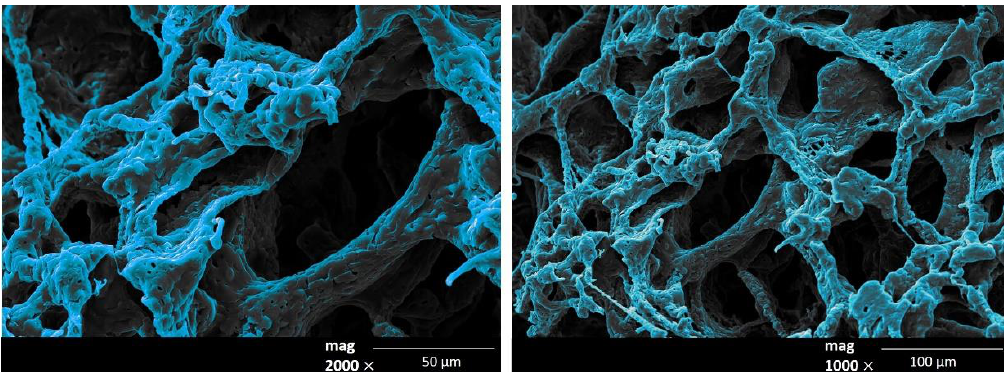
Figure 1. Scanning electron microscopy of the FC gel.